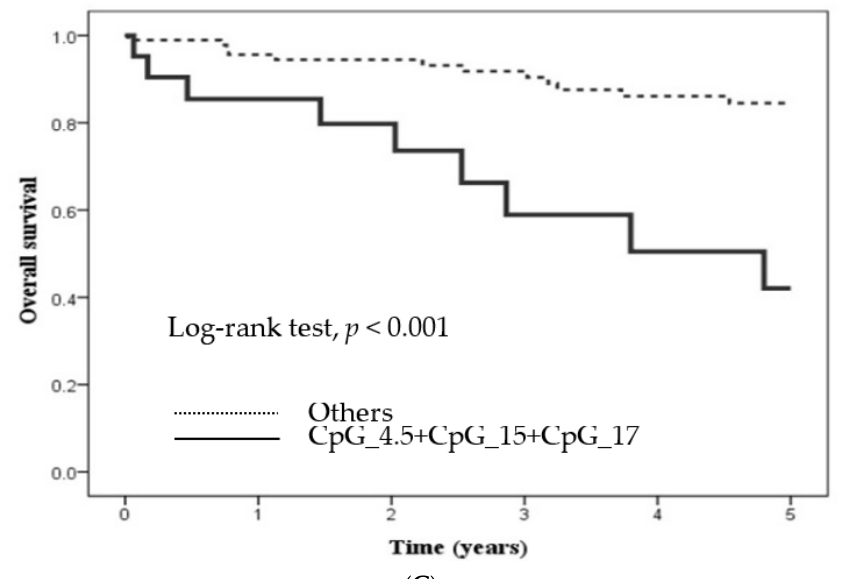
Figure 2. Clinical outcome of PTGER4 hypermethylation at CpG_4.5+CpG_15+CpG_17 from tumor tissue on 5-year ( A ) recurrence-free survival, ( B ) progression-free survival, and ( C ) overall survival of patients with colorectal cancer using Kaplan–Meier method.